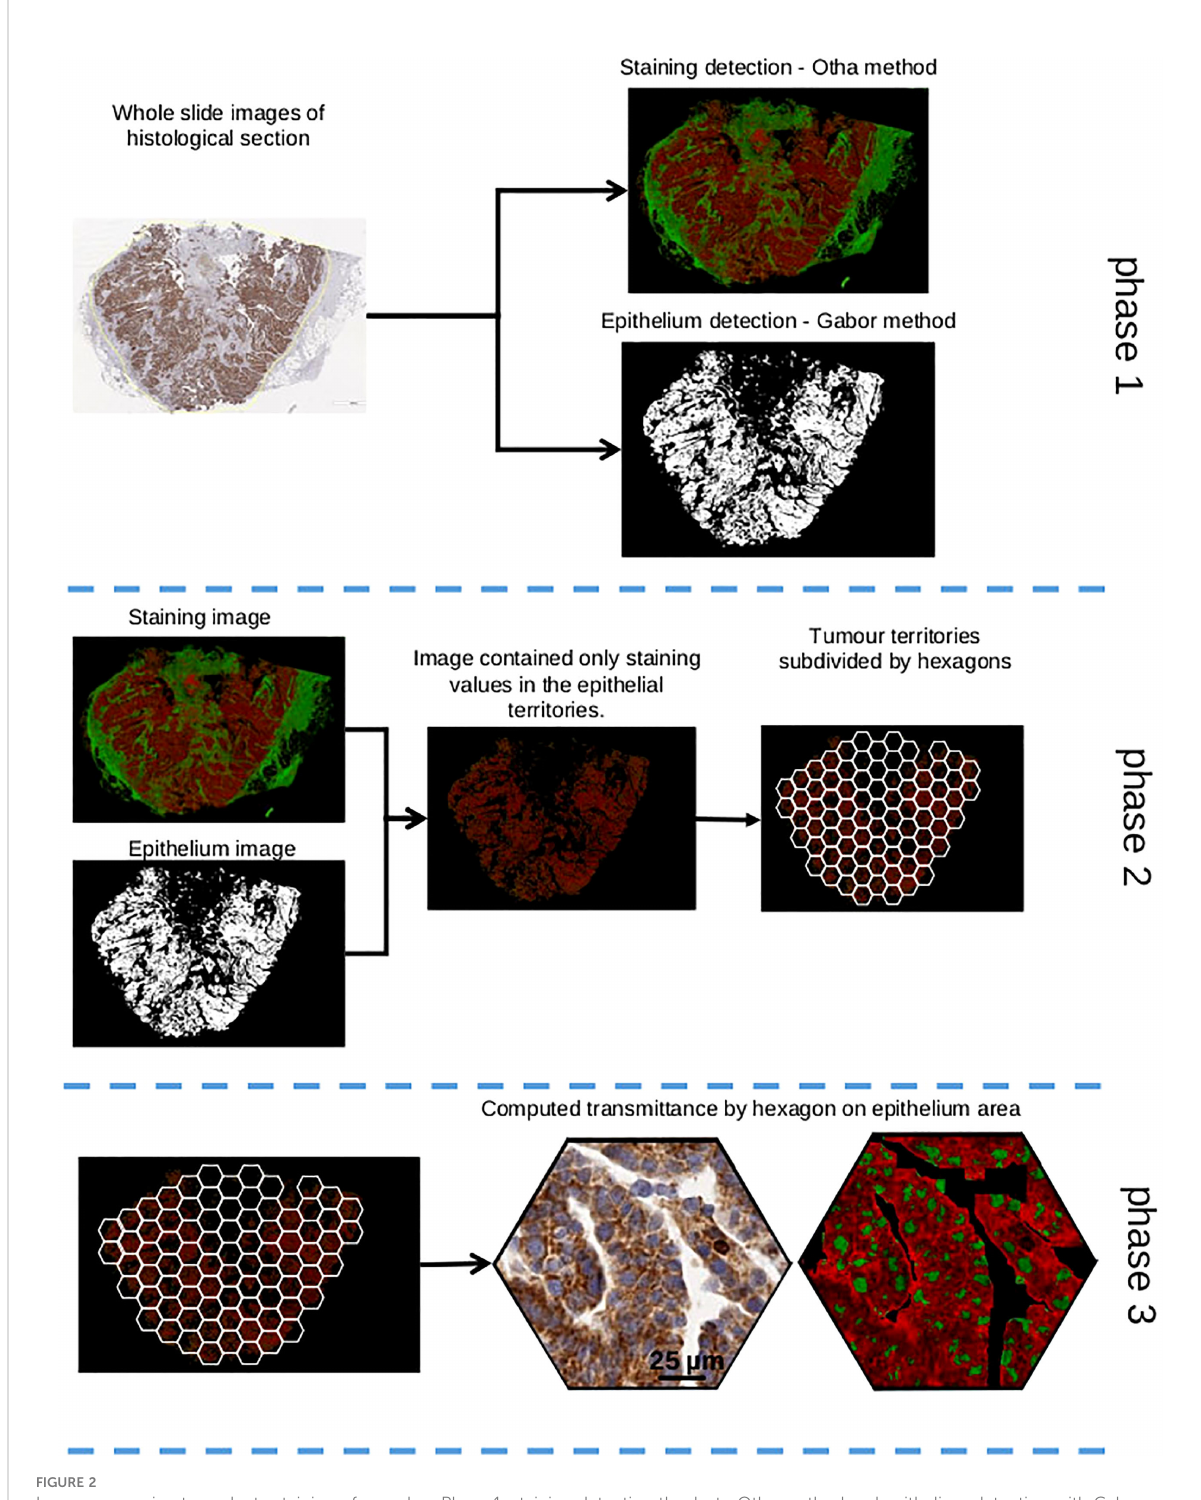
FIGURE 2 Image processing to evaluate staining of a marker. Phase 1: staining detection thanks to Otha method and epithelium detection with Gabor method. Phase 2: epithelium mask and staining image were mixed to keep only epithelium territories. This image is subdivided by hexagon pattern. Phase 3: in each hexagon, transmittance of staining is computed only in epithelial